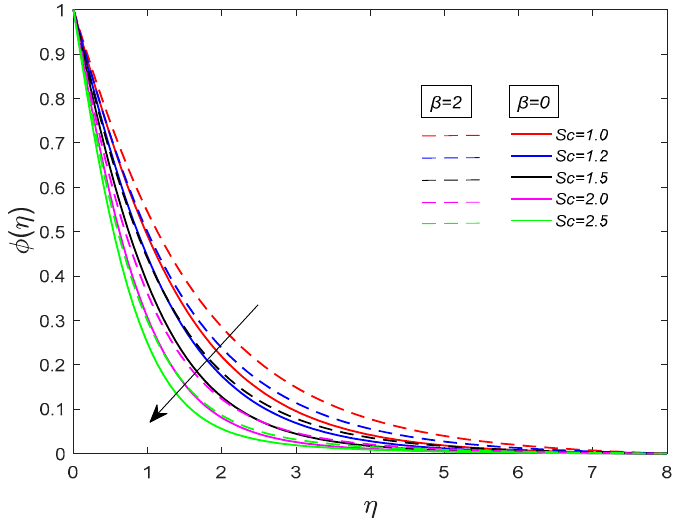
Figure 14. Effect of the Schmidt number (Sc) on concentration profile with Pr = 0.7, M = 0.5, Ec = Kr = Sr = 0.1.